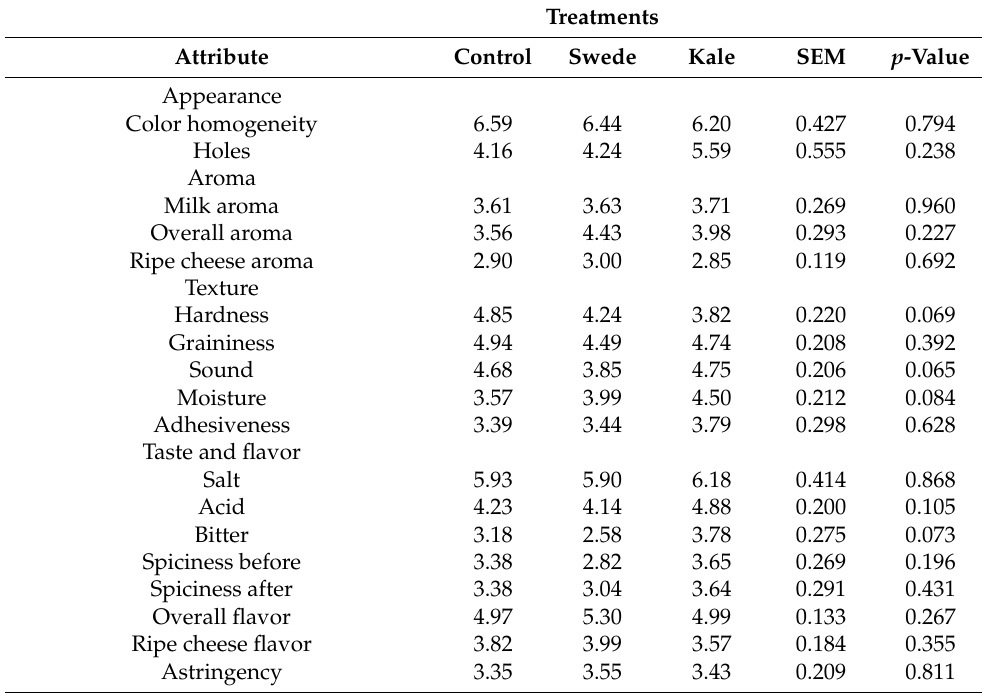
Table 5. Sensory characteristics of Chanco-style cheeses made with milk from dairy cows fed control or supplemented with kale or